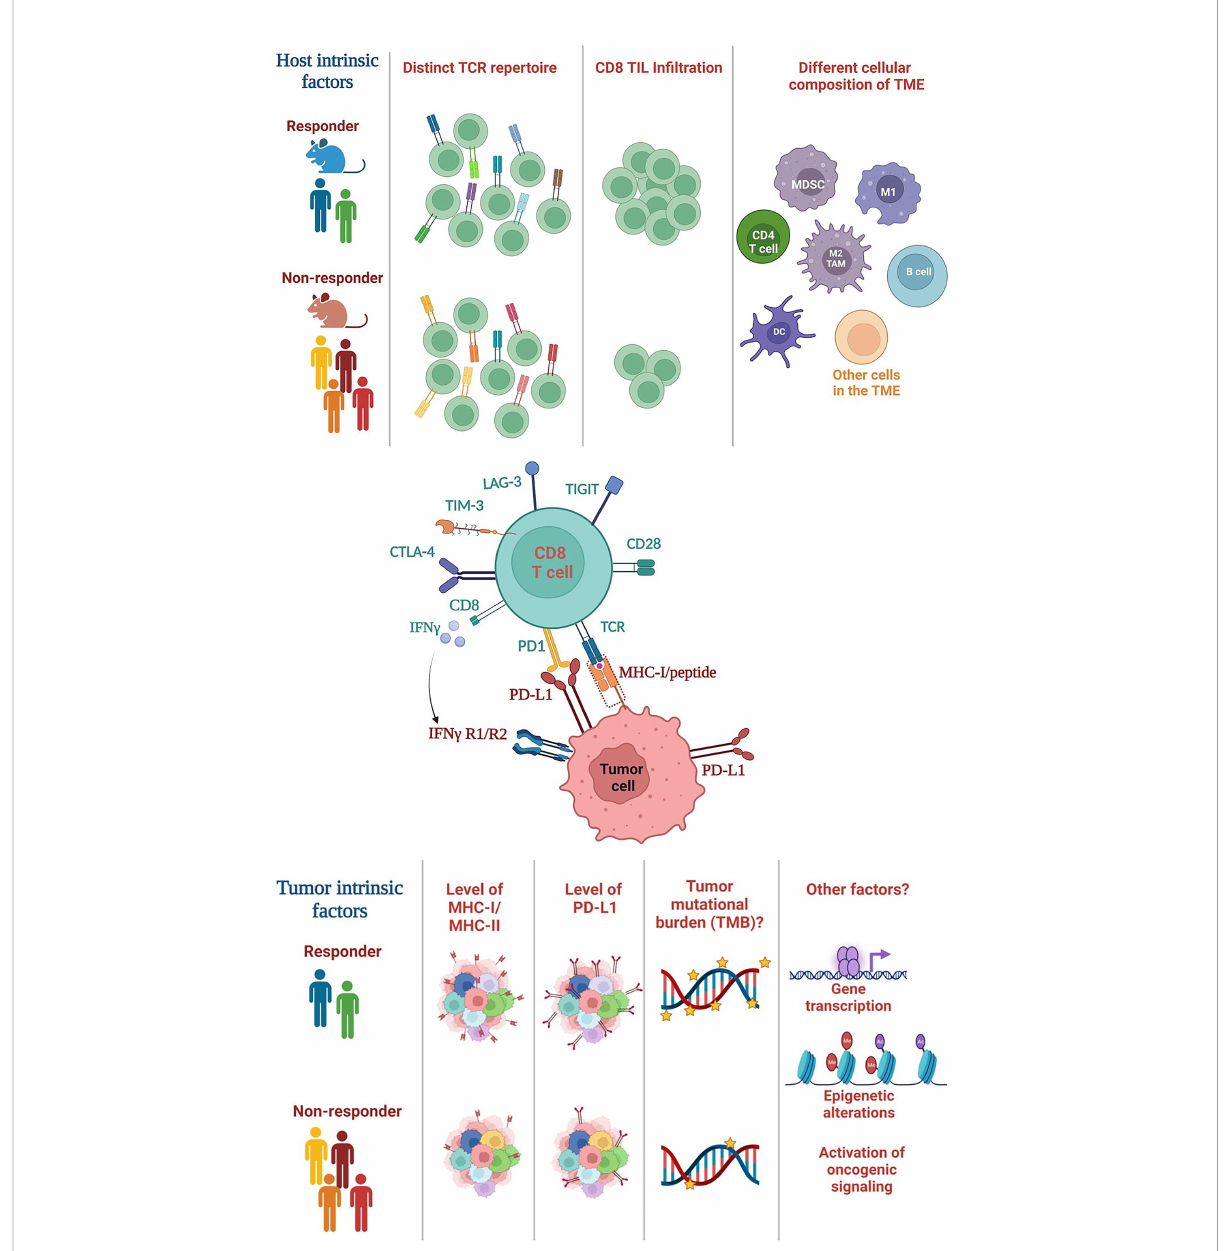
FIGURE 1 Summary of host-intrinsic and tumor-intrinsic factors that may in fl uence the heterogeneous outcomes of ICI treatment. (Top) Host-intrinsic factors: (1) distinct TCR repertoires in responders vs. non-responders, (2) different level of CD8 TIL in fi ltration, (3) different cellular composition of the TME. Various subsets of immune cells are shown including CD4 T cells, B cells and myeloid cells, whereas many subsets of other cells in the TME are not shown including NK cells, Tregs, fi broblasts etc. TCR, T cell receptor; TIL, tumor-in fi ltrating lymphocyte; TME, tumor microenvironment. (Middle) The interaction between CD8 T cells and tumor cells. CD8 T cells recognize the MHC class I/peptide complex present on tumor cell surface. CD8 T cells can express various exhaustion markers including PD-1, TIM-3, LAG-3 etc. CD8 T cells can also secrete cytokines such as IFN- g , while tumor cells express IFN g receptor (IFN g R). (Bottom) Tumor-intrinsic factors: (1) differential level of MHC class I or class II expression, (2) PD-L1 expression on tumors (shown) or other cells in the TME (not shown), (3) the level of TMB, and (4) other potential factors such as genetic or epigenetic alterations in tumor cells, differential transcriptomes; activation of different oncogenic signaling pathways. TMB, tumor mutational